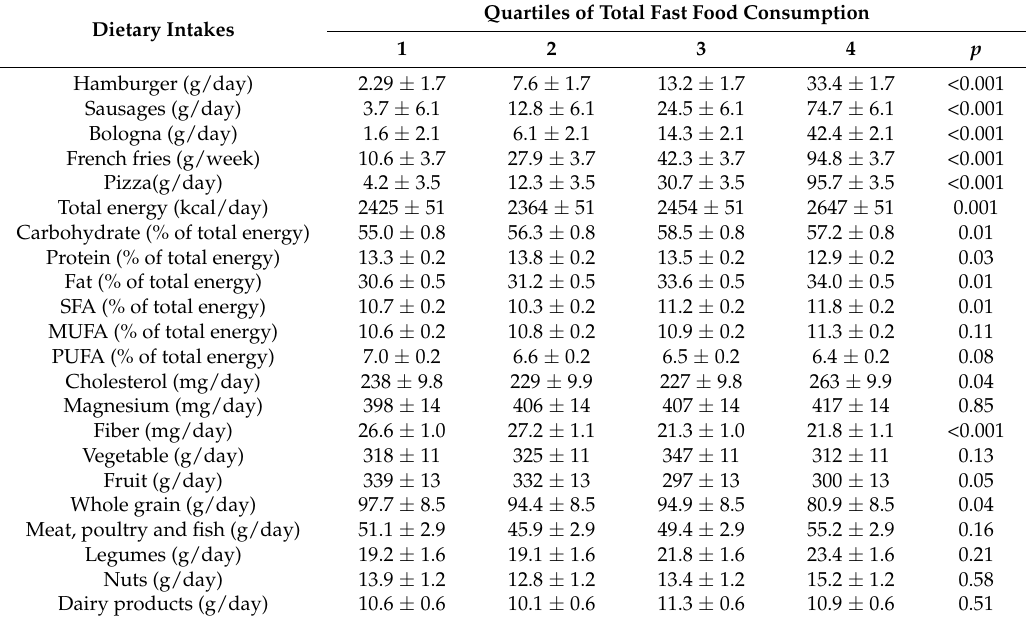
SFA, saturated fatty acids; MUFA: mono-unsaturated fatty acids; PUFA, poly unsaturated fatty acids. Data are mean ± SEM (adjusted for energy